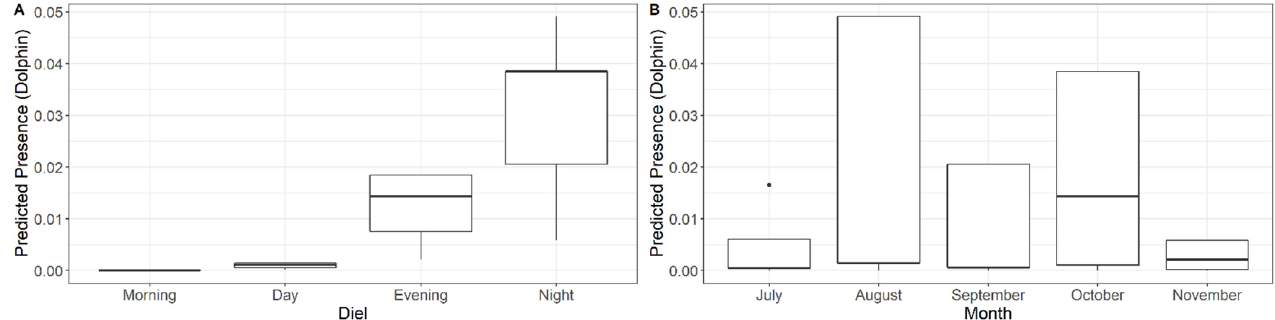
Figure 3. The predicted probability of bottlenose dolphin presence at the Maharees according to: ( A ) the time of day, where the four categories of diel phase are “Morning”, “Day”, “Evening”, and “Night”; ( B ) month, from July to November.